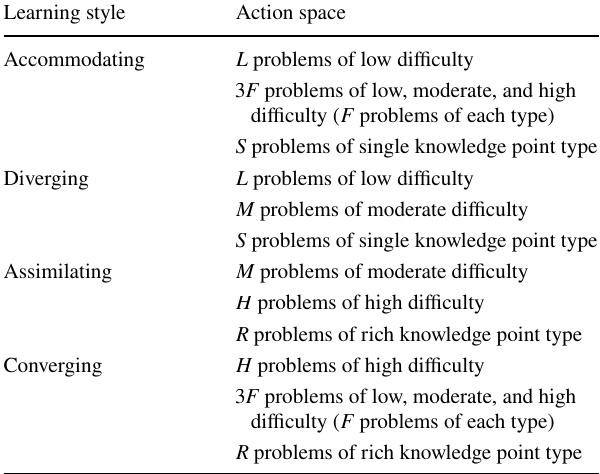
Table 2 Correspondence between learning style and action space Learning